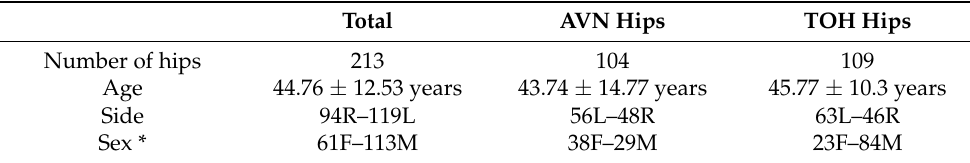
Table 1. Patient